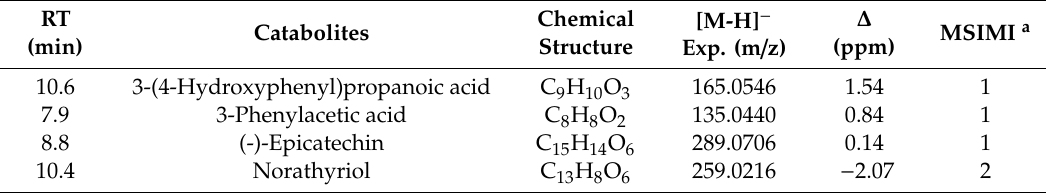
Table 3. UHPLC-HRMS Characteristics of Mango Polyphenol Catabolites Identified after fecal